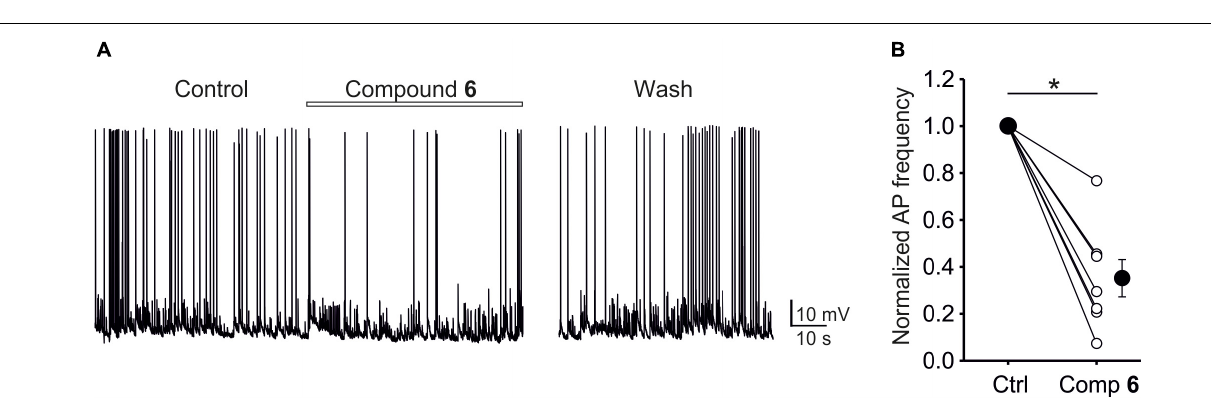
FIGURE 10 | The effect of compound 6 on network activity in primary hippocampal cultures. (A) Example current-clamp trace showing control activity, activity in the presence of 10 µ M compound 6, and following a period of wash. (B) Plot of normalized AP frequency before and during compound 6 application. Small circles show data from individual cells, large circles show mean data. Asterisks mark significance at the level of P < 0.001 (Paired t